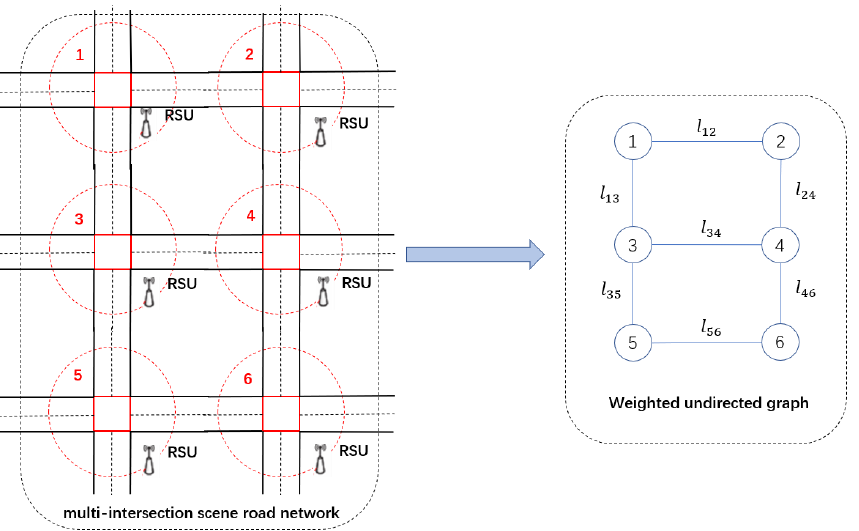
Figure 2. The weighted undirected graph describes the road network. Numbers 1–6 indicate the intersection number. intersection